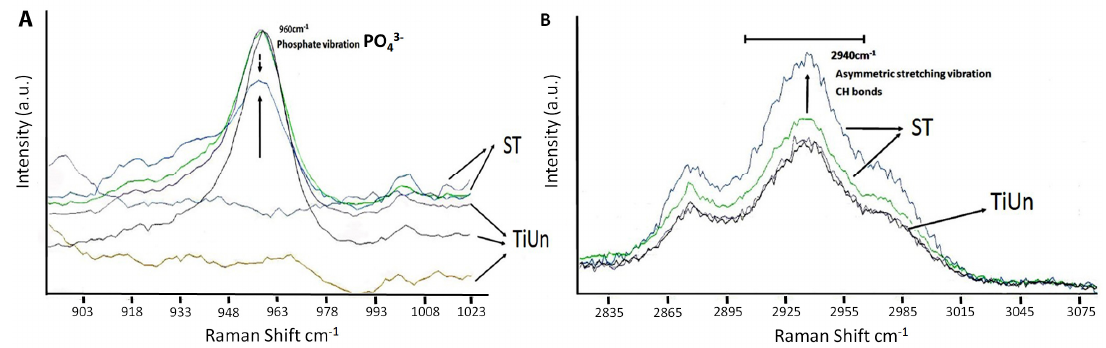
Figure 4. ( A ) Representative micro ‐ Raman spectra recorded on the surface of received implants at a laser power of 5 mW showing marked differences within the intensities attributed to symmetric stretching vibration of PO 3 − (inorganic phosphate); ( B ) Representative micro ‐ Raman spectra recorded 4 on the surface of the implants showing the main peak centered at 2940 cm − 1 related to CH bonds.